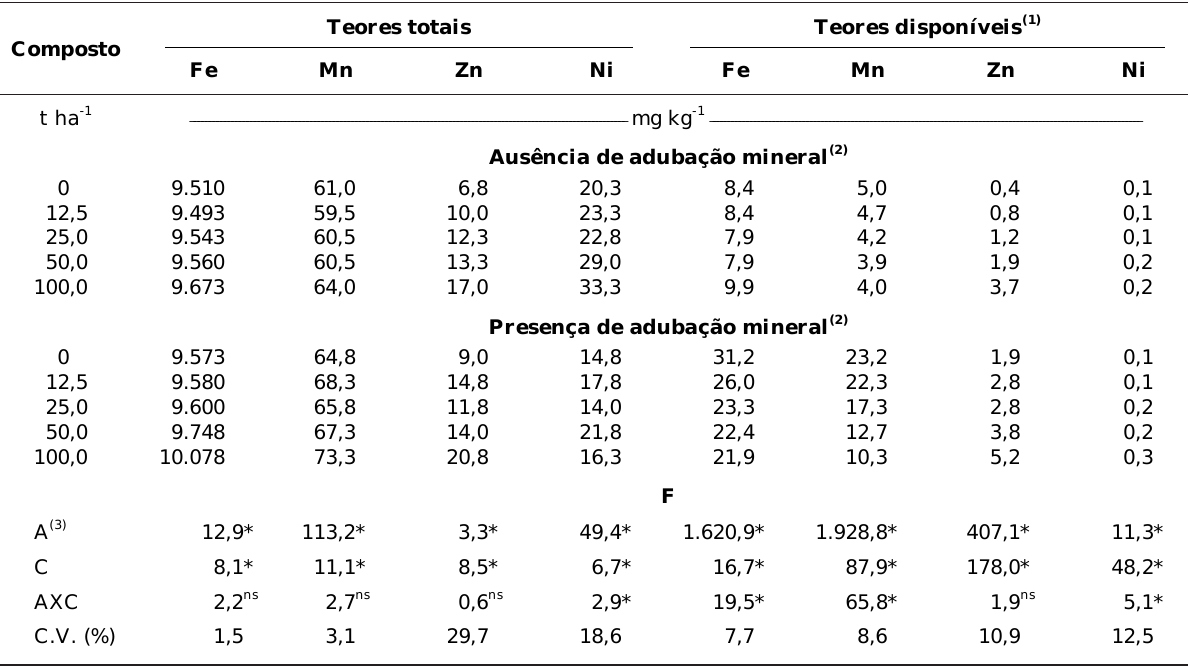
teste F: * e ns significativo a 5% e não-significativo, respectivamente. (3) A = fator adubação química; C = fator dose de composto e AXC = interação dos fatores.